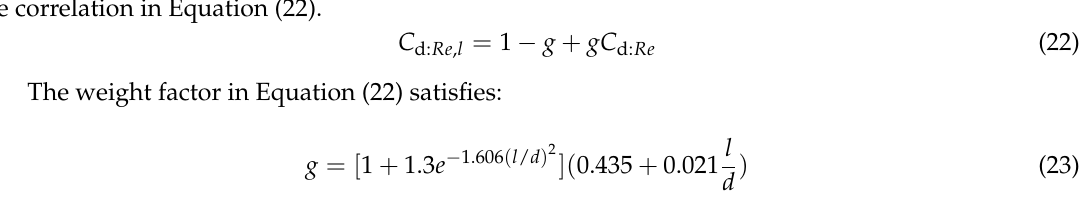
Figure 11. Illustration of leakage with inlet cross-flow.